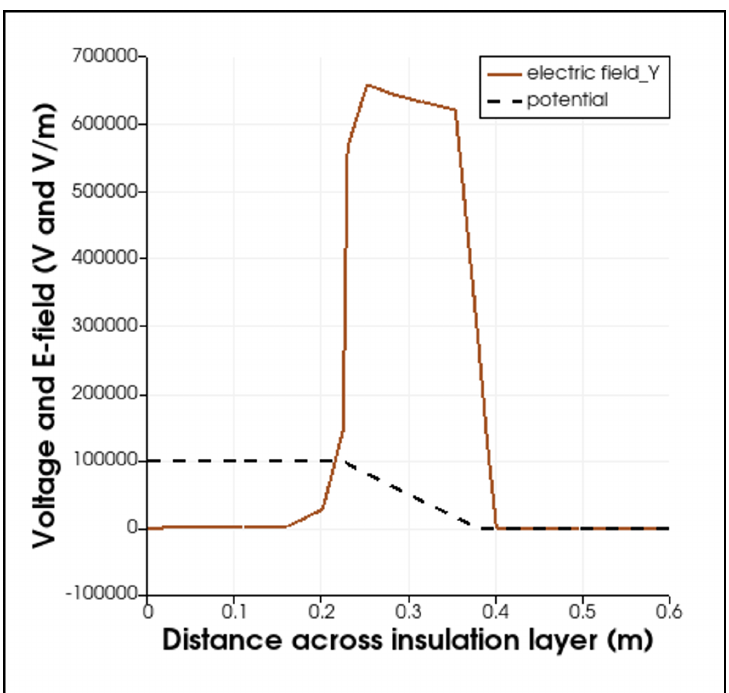
Figure A3. Voltage and fields across the insulation